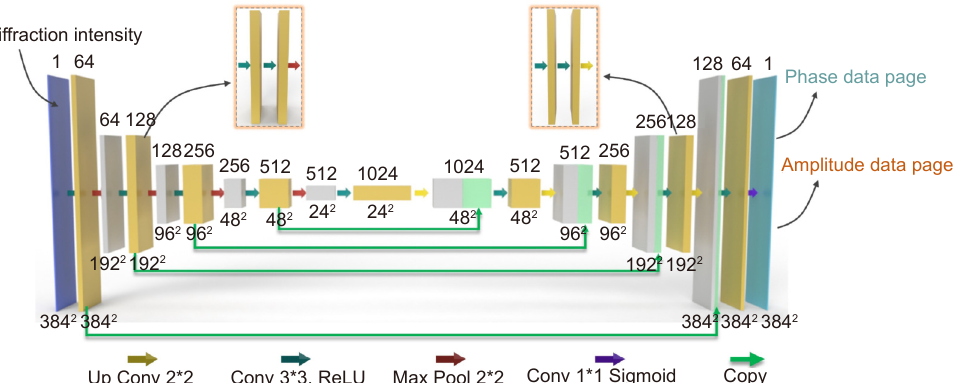
Fig. 7 | Architecture of the convolutional neural network.